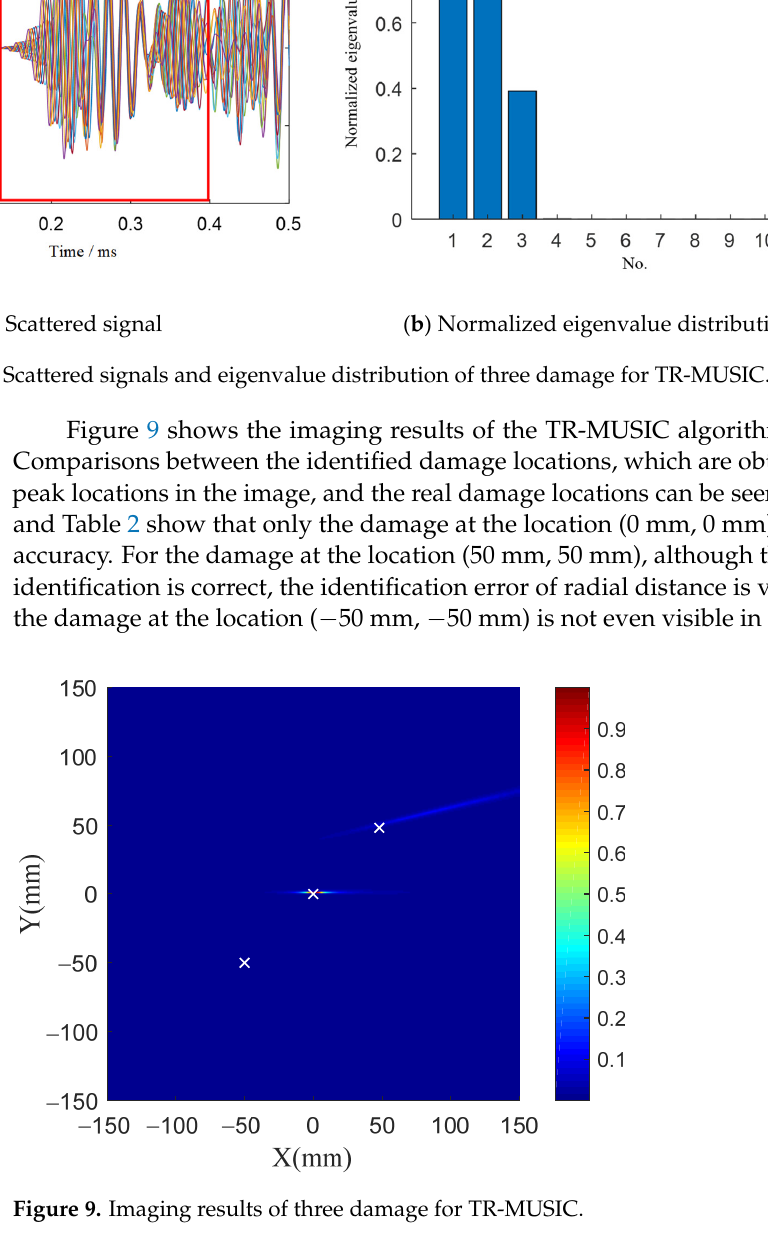
Figure 9. Imaging results of three damage for TR ‐ MUSIC.